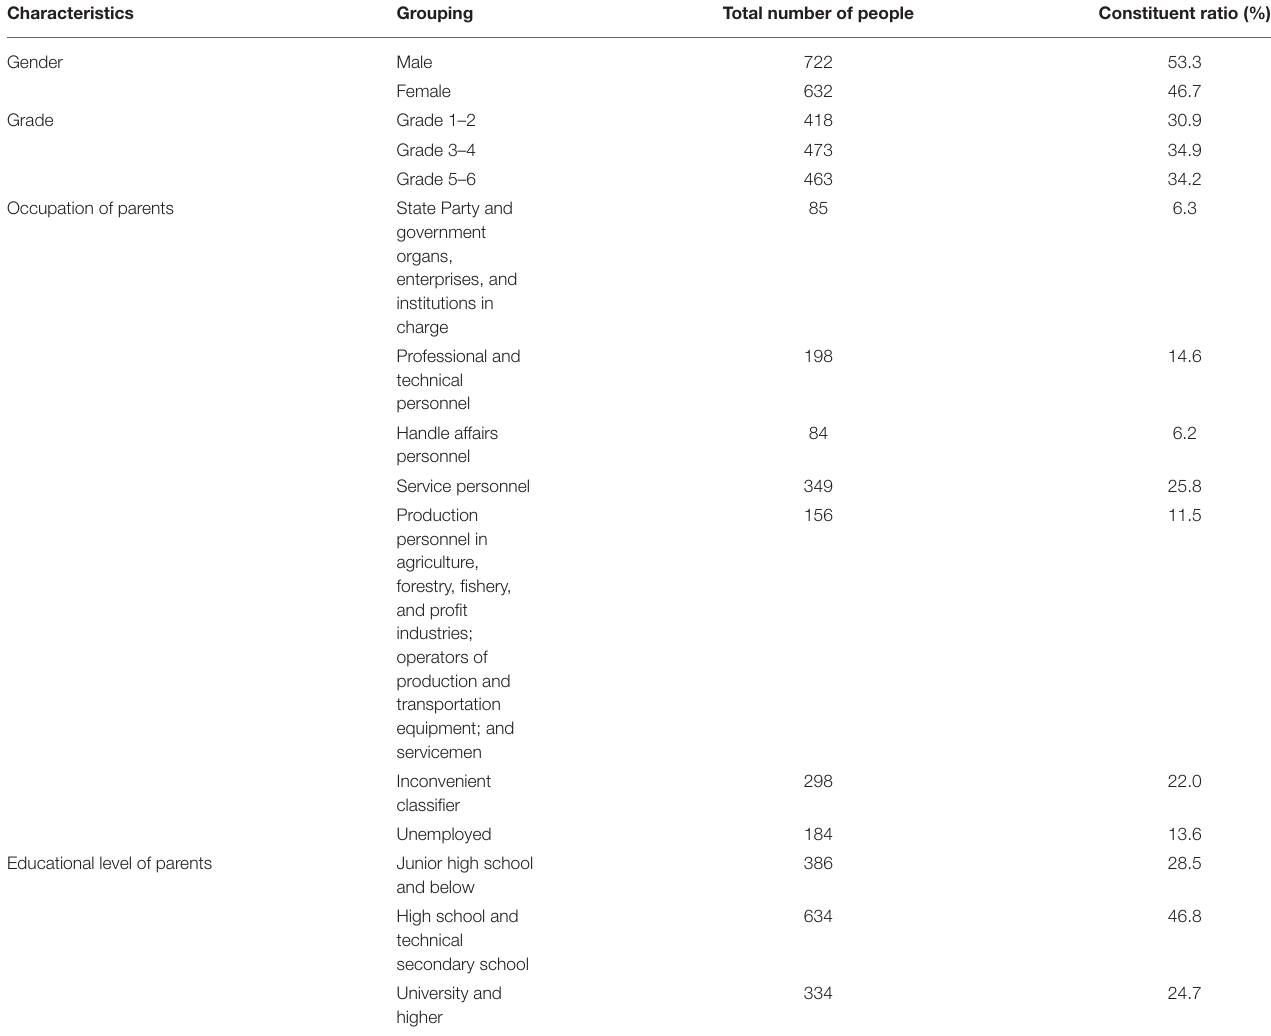
TABLE 1 | Demographic characteristics of the subjects ( n = 1,354).